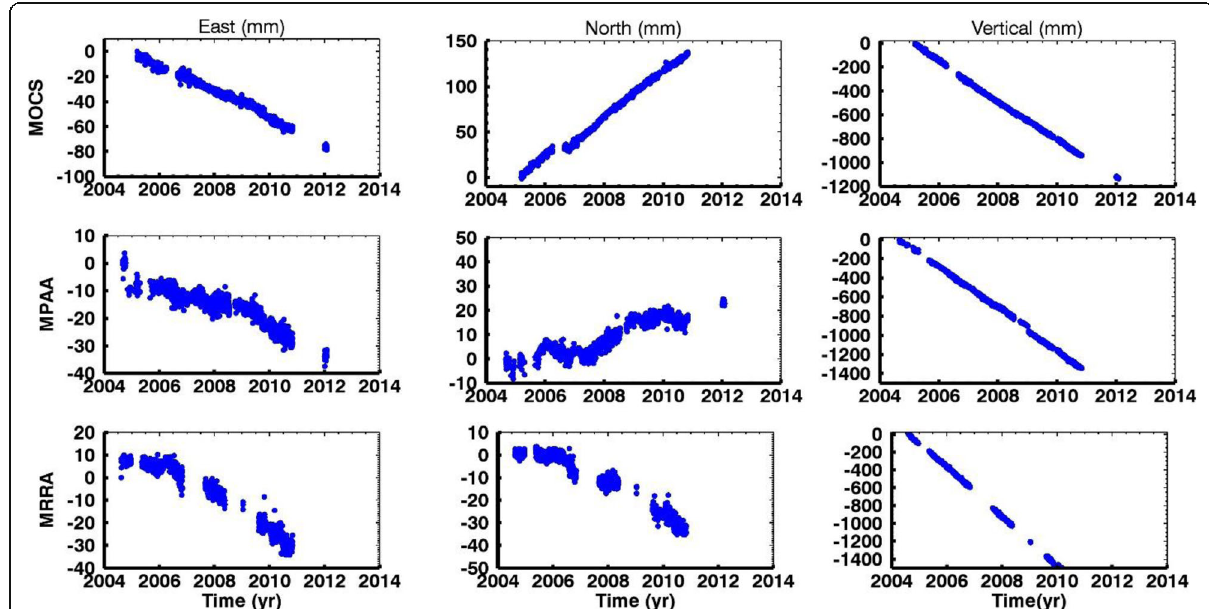
Fig. 4 North, east, and vertical components of motion observed by the permanent GPS stations (blue points) using point positioning and the ITRF-2000 reference frame. GPS rates are provided in Table 1